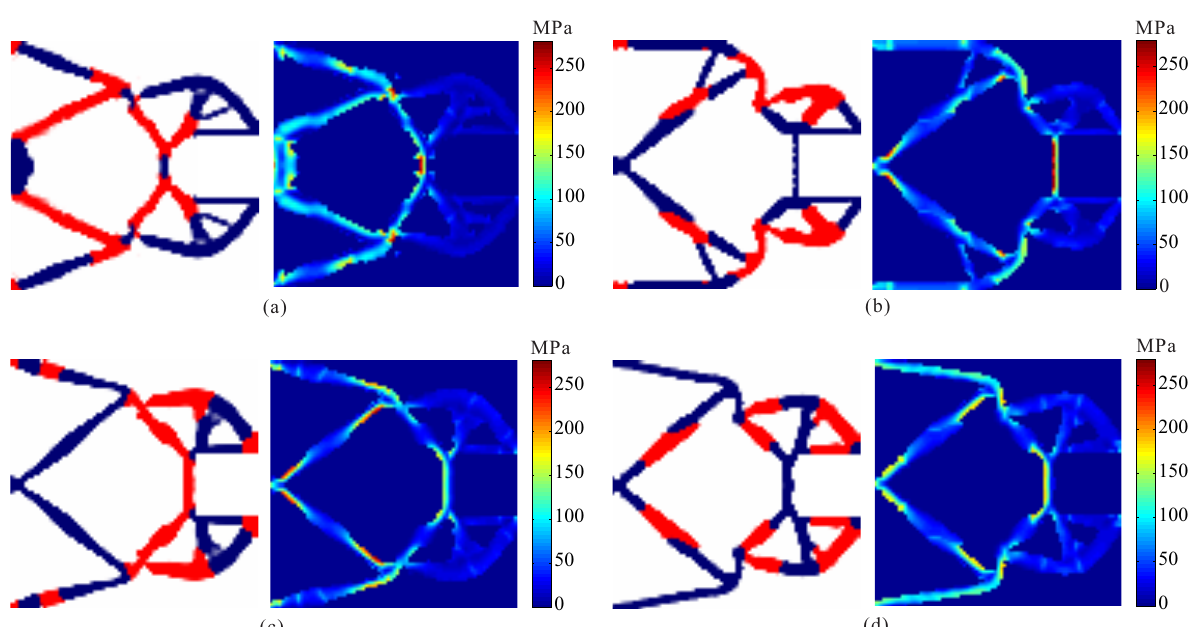
Figure 11. The results for topological design of multi-material compliant gripper under different output spring stiffness.